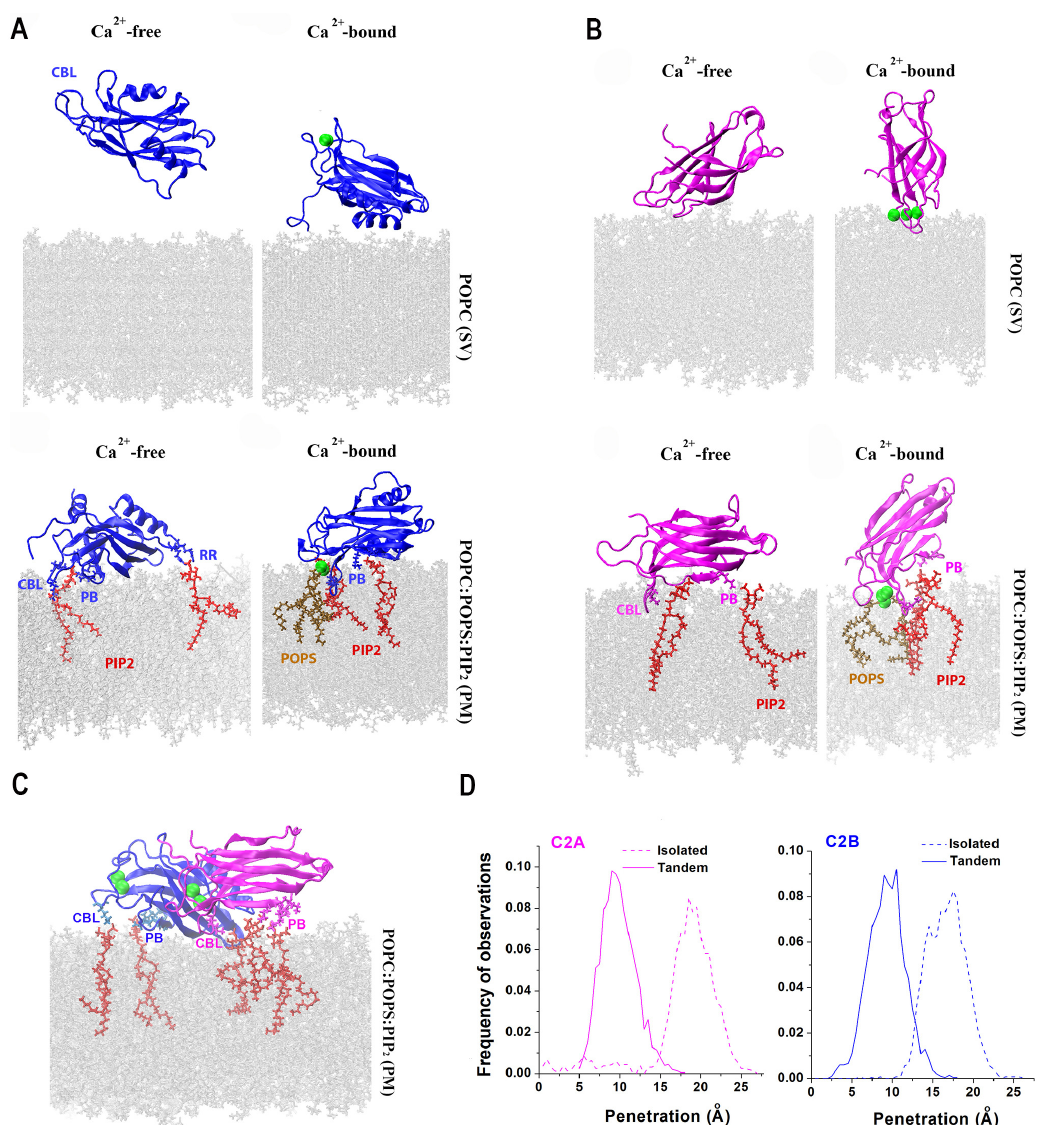
Figure 3. Lipid binding of the isolated domains, as well as the C2AB tandem of Syt1. ( A ) The C2B domain binds the bilayer mimicking the PM via its Ca 2+ binding loops (CBL), polybasic stretch (PB), and the RR (Arg398-Arg399) motif opposing the CBL. Green spheres denote Ca 2+ ions. Red: PIP2. ( B ) CBL of the C2A domain attach to either the SV or PM bilayer; however, the interaction with the PM bilayer is more extensive and the penetration into the PM is deeper. ( C ) Both C2 domains within Ca 2+ C2AB tandem attach to the PM via their CBL and PB motifs. ( D ) The penetration into the PM bilayer is deeper for the isolated Ca 2+ -bound C2 domains compared to the Ca 2+ C2AB tandem. Reproduced from